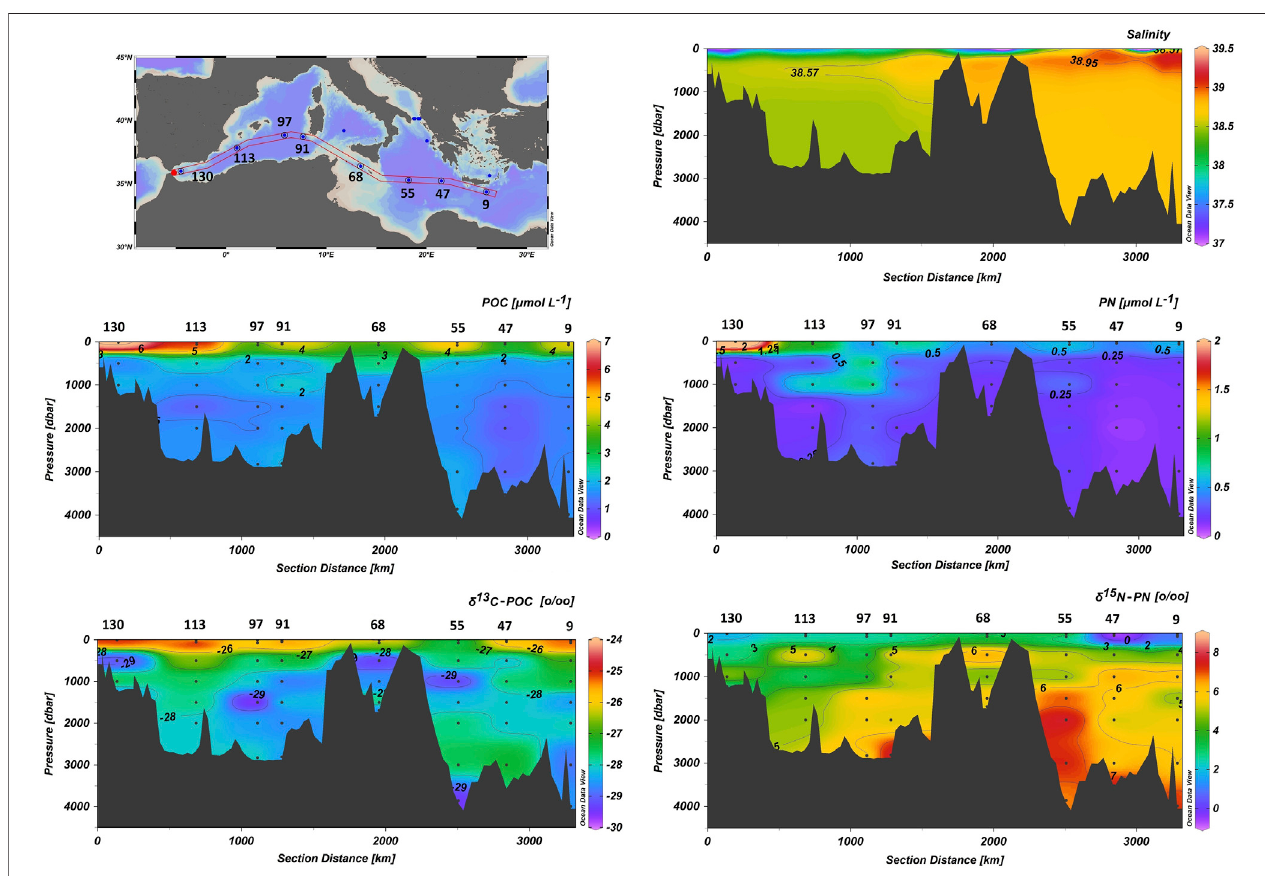
FIGURE5 | West-east section ofsalinity, POC and PN contents, δ 13 C-POC and δ 15 N-PN values in theMediterranean Sea. Section location isshown inthe upper left panel. Dots correspond to the sampled depths.